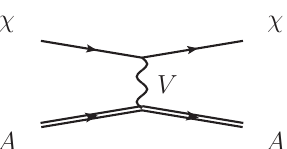
Figure 1: Leading order Feynman diagram for DM scattering on a nucleus via the exchange of a vector